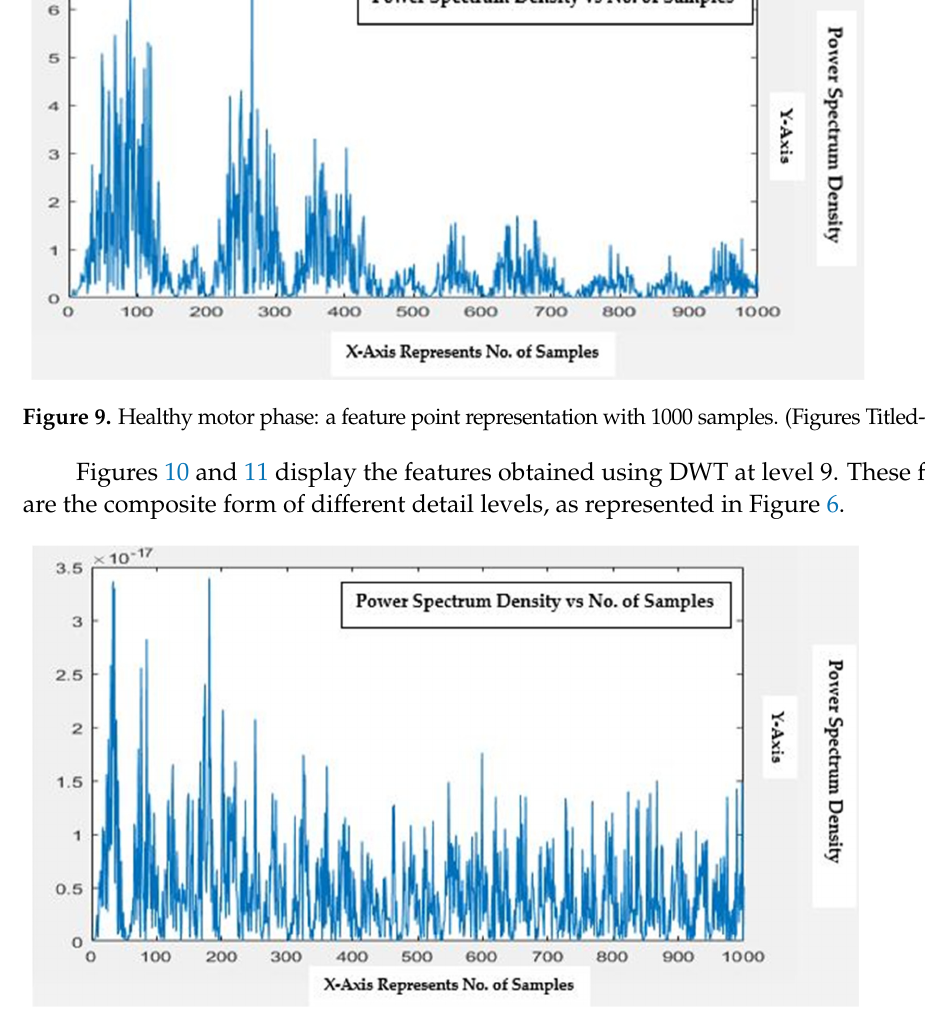
Figure 10. High contact resistance fault in Phase-A: Representation of feature points with 1000 samples. (Figures Titled-300 dpi).